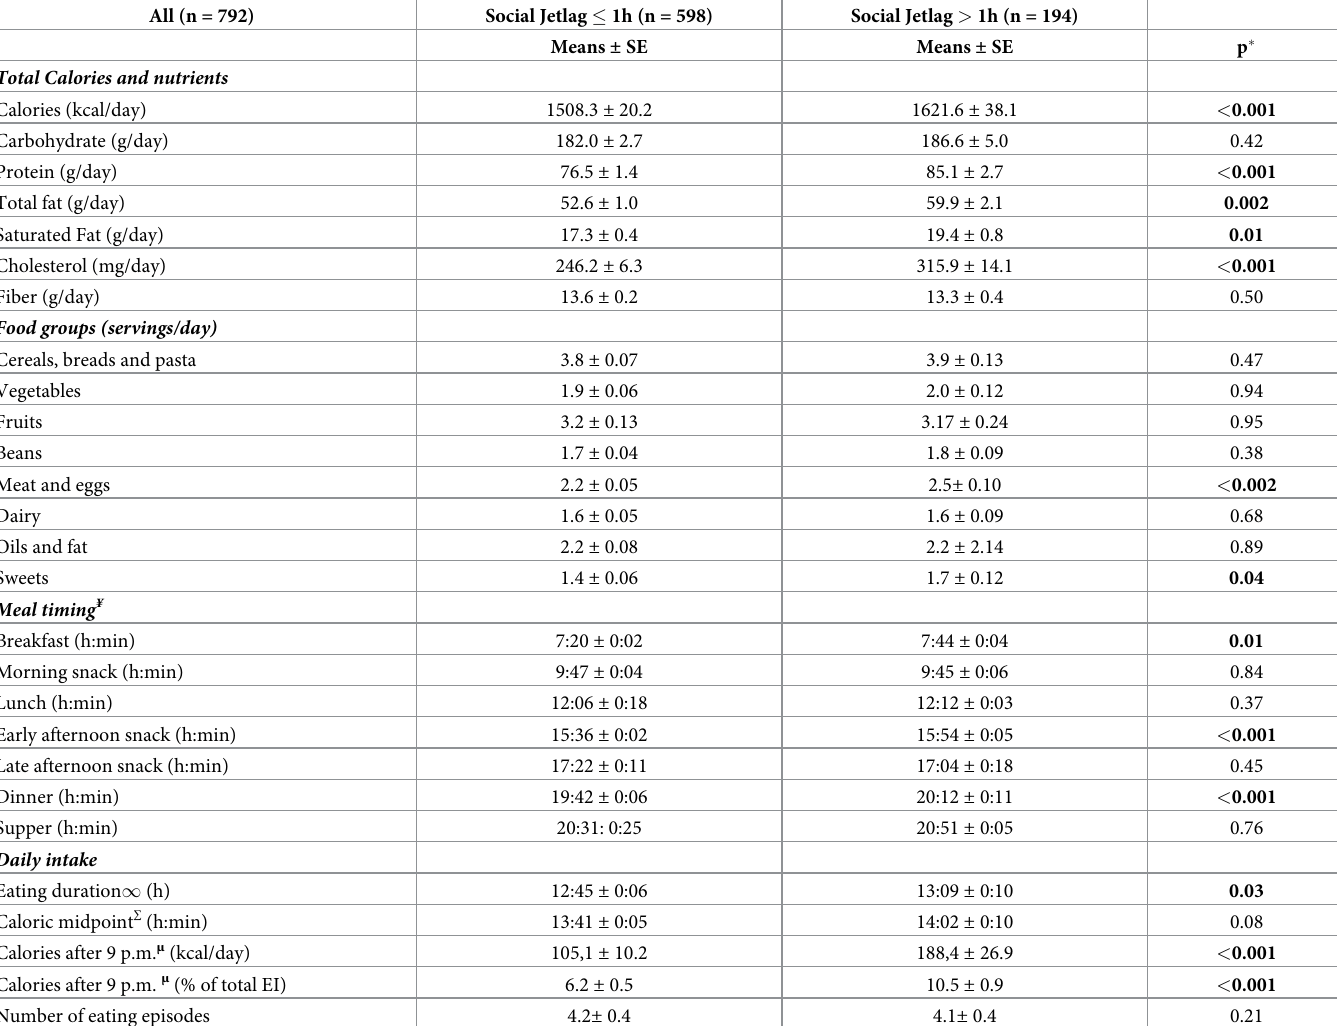
Table 2. Association of social jetlag on food consumption, meal timing and circadian intake according to absence of social jetlag ( � 1h) or presence ( > 1h) (n = 792). All (n =